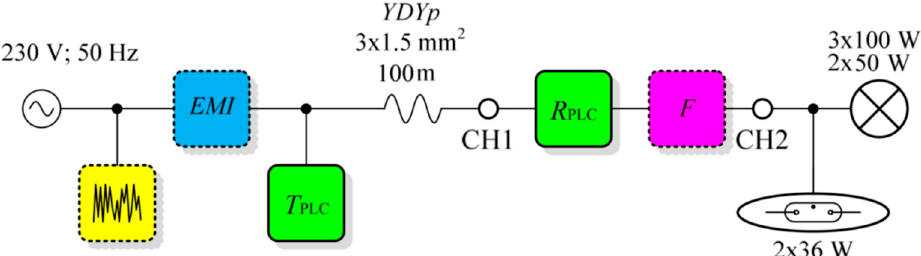
Figure 18. Connection schematic of the model with an EMI filter while LED lighting systems with power supplies and a fluorescent lamp with a power supply system working as the receiver, the receivers were connected with the proposed filtering system (TEST 3).